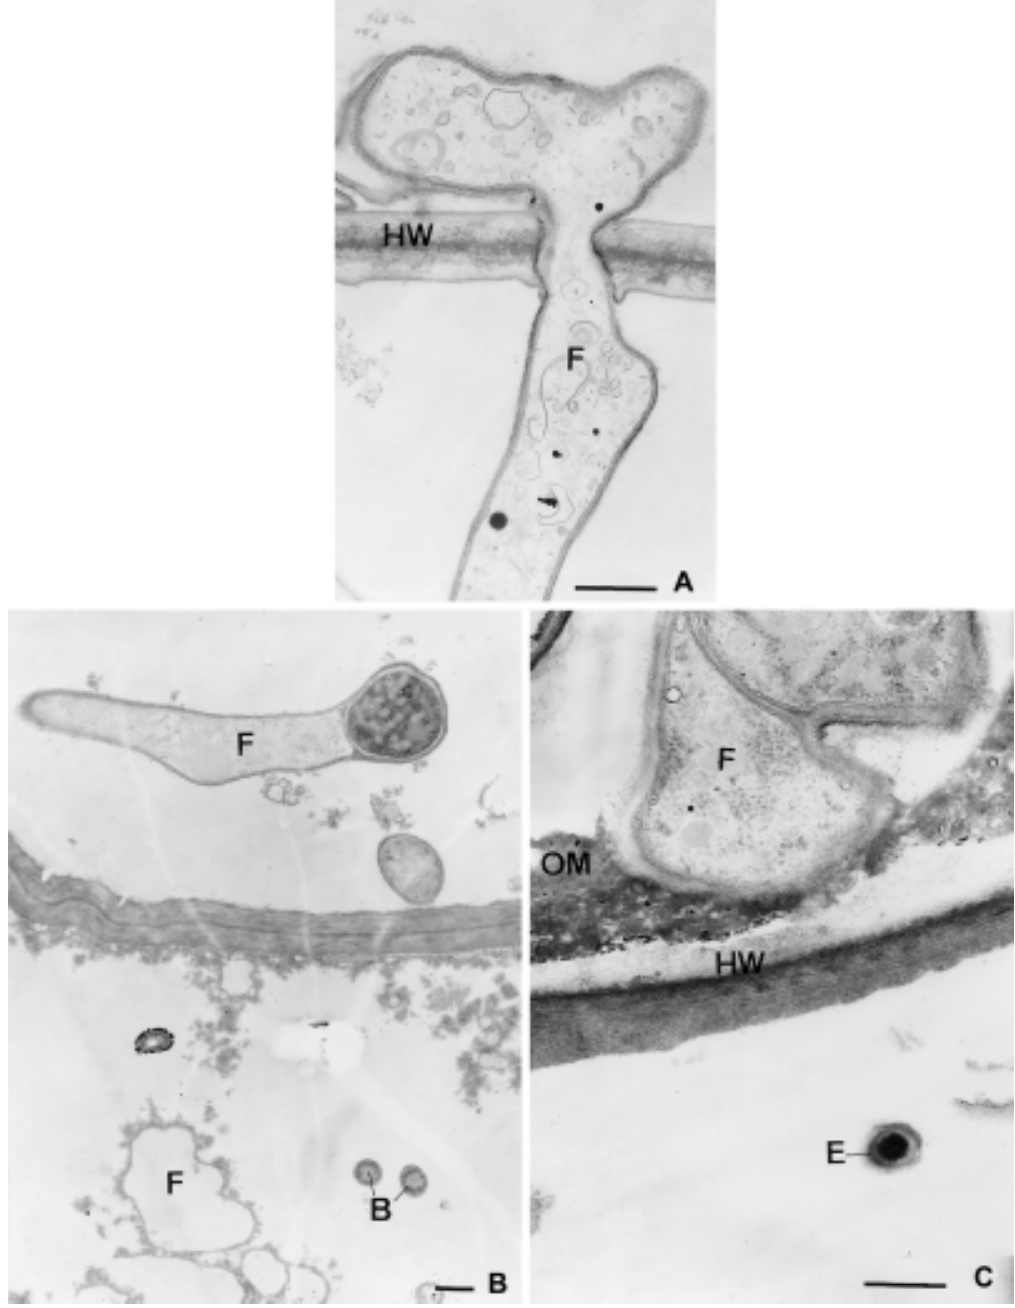
Fig. 4. TEM sections of potato cv. Spunta tissues 7 days after bacterization with Bacillus cereus X16 and challenge with Fusarium roseum var. sambucinum . An antagonistic bacterium observed as vegetative cells (B) or as a resist- ant endospore (C) in host tissues colonized by the fungal pathogen; (A) fungal hyphae exhibiting marked altera- tions; (C) a thick layer of osmiophilic polymorphic material deposited between the fungus and the primary host cell wall. Bar = 1 mm. B, bacterium; E, endospore; F, fungus; HW, host wall; OM, osmiophilic